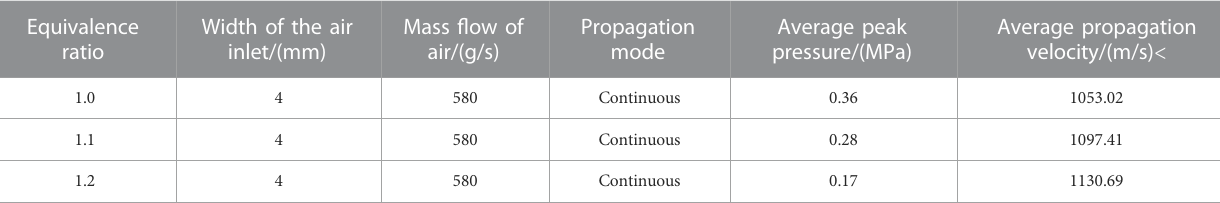
TABLE 2 Experimental parameters with different equivalent